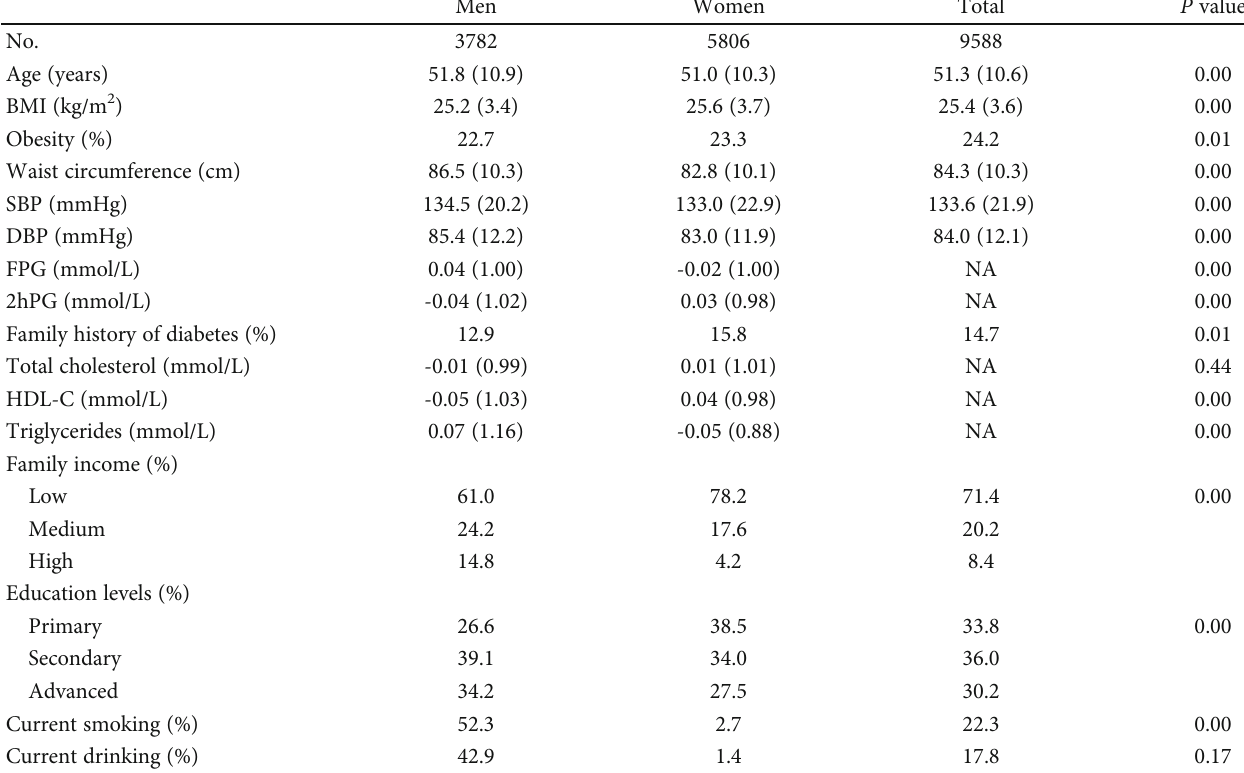
Table 1: Baseline characteristics of study